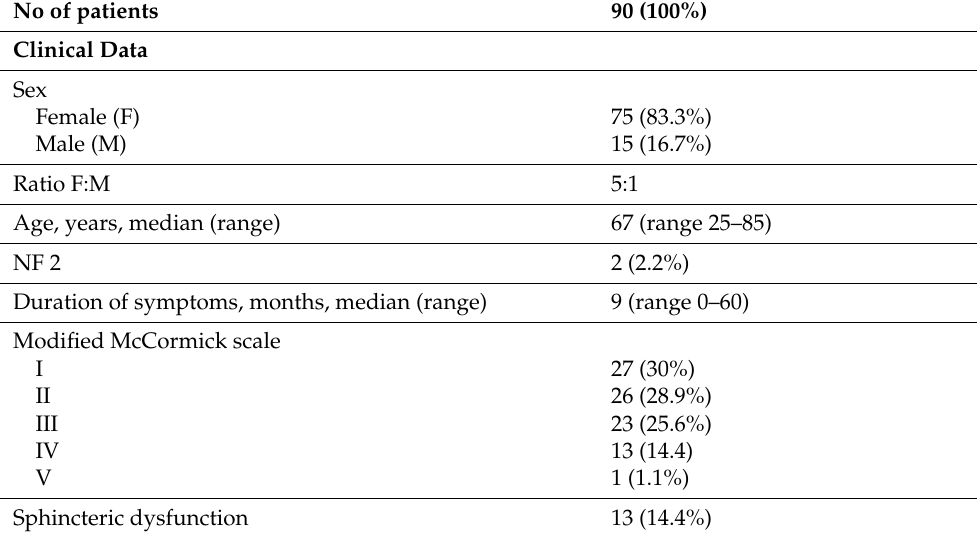
Table 2. Preoperative clinical and radiological features of the patient